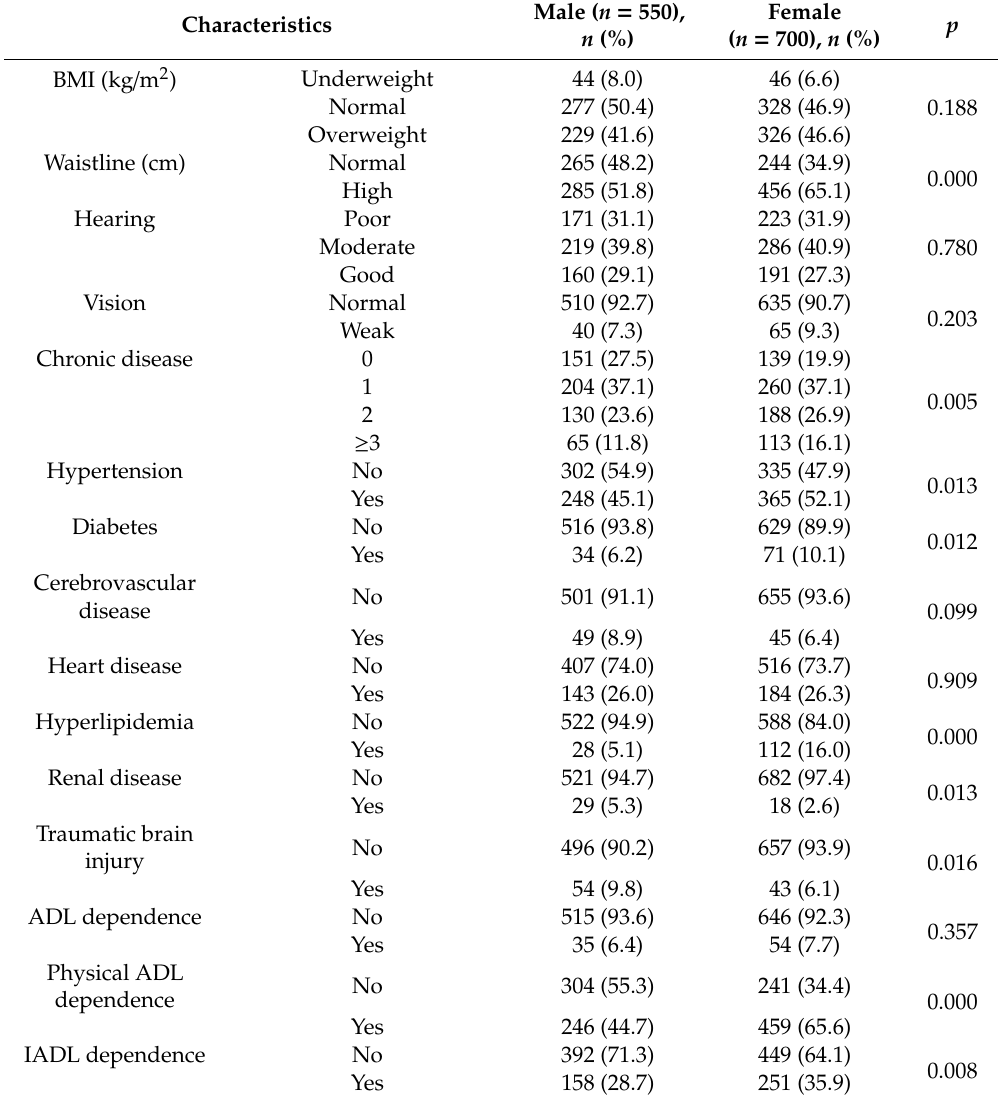
Table 2. Health-related characteristics of study